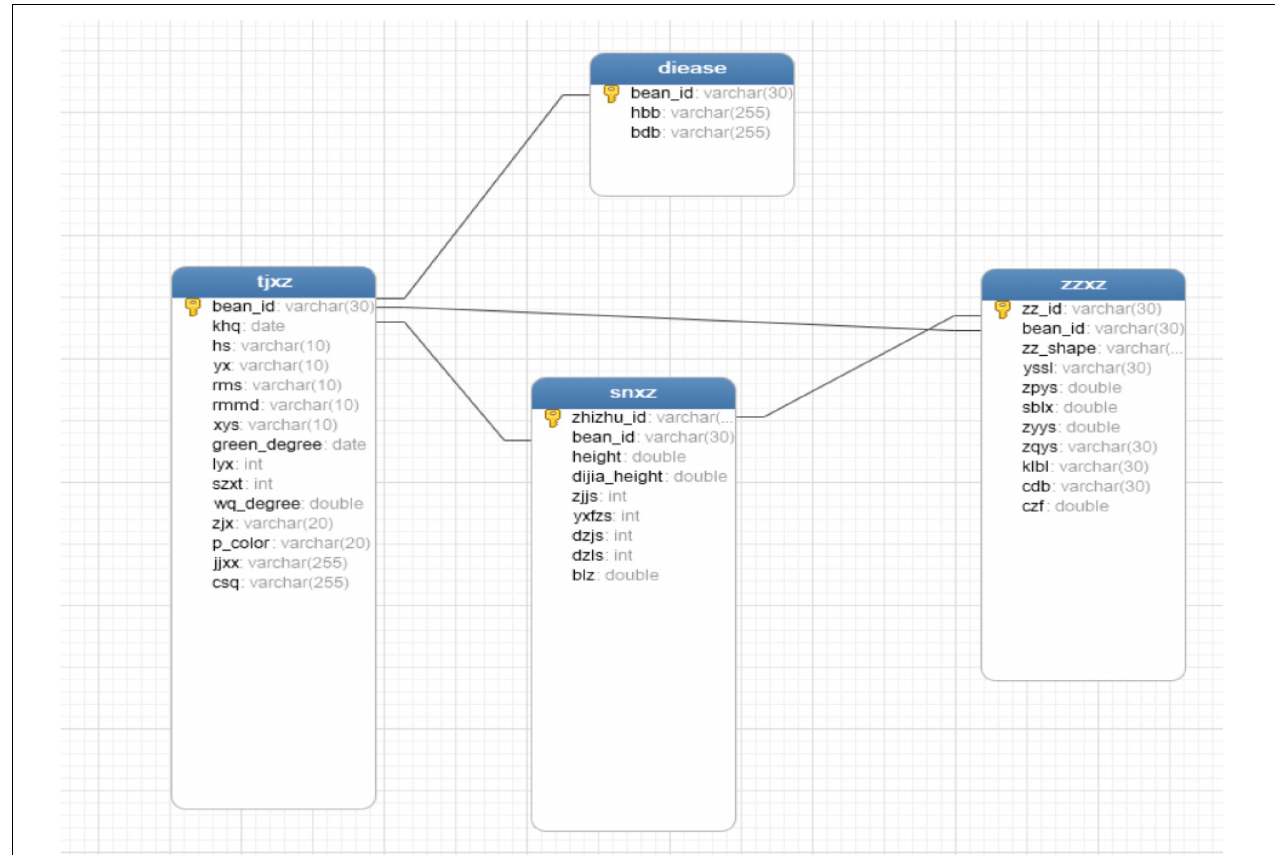
FIGURE 13 | Original ER